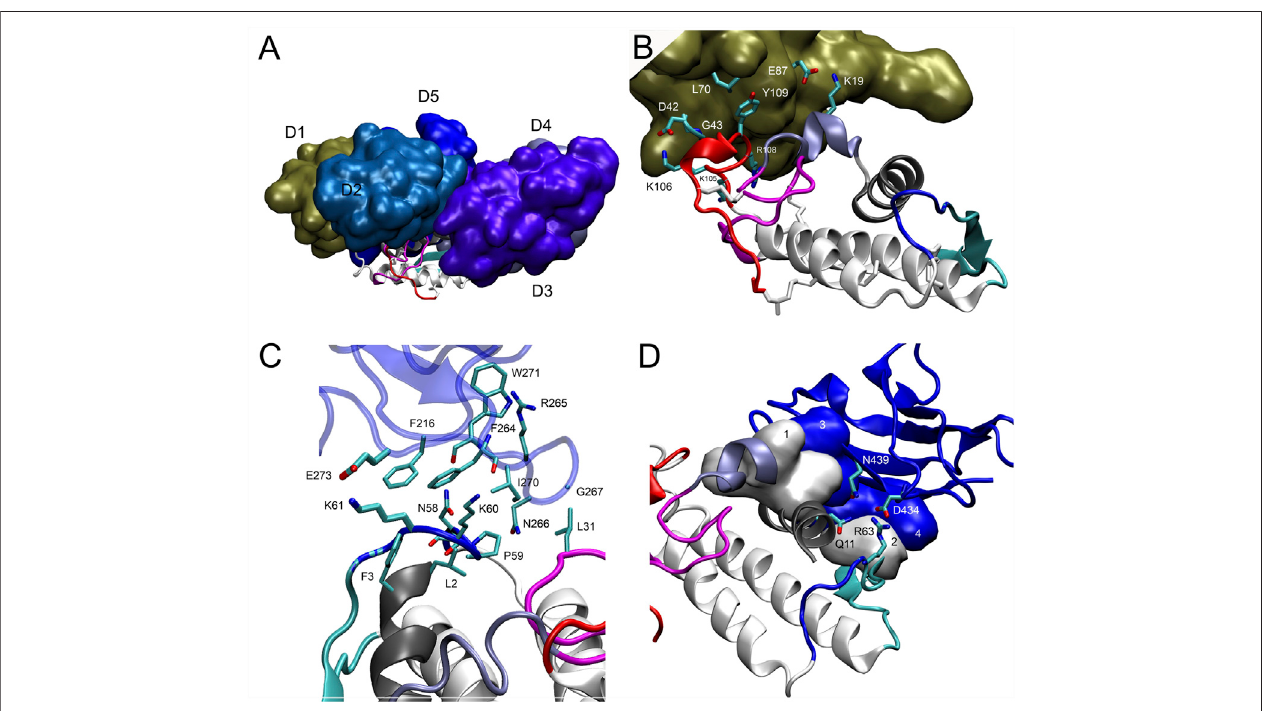
FIGURE 7 | Interaction of myotoxin II and DM64 domains. (A) Lateral view of the complex model following the same color scheme of Figure 6 . DM64 interacts throughout the curved interface of myotoxin II. Despite the complementarity of the surfaces, myotoxin II C-terminal peptide (colored in red) remains free. (B) Domain D1 (chainA)interactswiththeMDoSresiduesK19,K105,andR108ofmyotoxinII(chainF).TheinteractionsurfaceencompasseshydrophobiccontactsbetweenTyr109F/ Leu70Aandtwolong-livedhydrogen bondsbetweenLys106F/Asp42AandLys19F/Glu87A. (C) DomainD3(chainC)interactswiththefrontalloop,precedingthe beta-wing. The surface encompasses hydrophobic contacts between myotoxin II residues Phe3, Leu2, Leu31, Pro59, and D3 residues Phe216, Phe264, Arg265, Asn266,Gly267,andIle270. (D) Domain D5(chain E)interacts withtheN-terminalhelix (gray) andbeta-wing(cyan)ofmyotoxinII(Chain F).Hydrophobiccontactsat the myotoxin II interaction surface were represented as numbered white surfaces 1 (Leu10, Gly14 Lys15, and Asn16) and 2 (Trp68). On domain D5, the interaction region comprises blue surfaces 3 (Leu441 and Ile403) and 4 (His390, Val392, and His393). Additionally, several hydrogen bonds showing long-lived nature were detected on the interface, such as Arg63F-Asp434E and Gln11F-Asn439E.